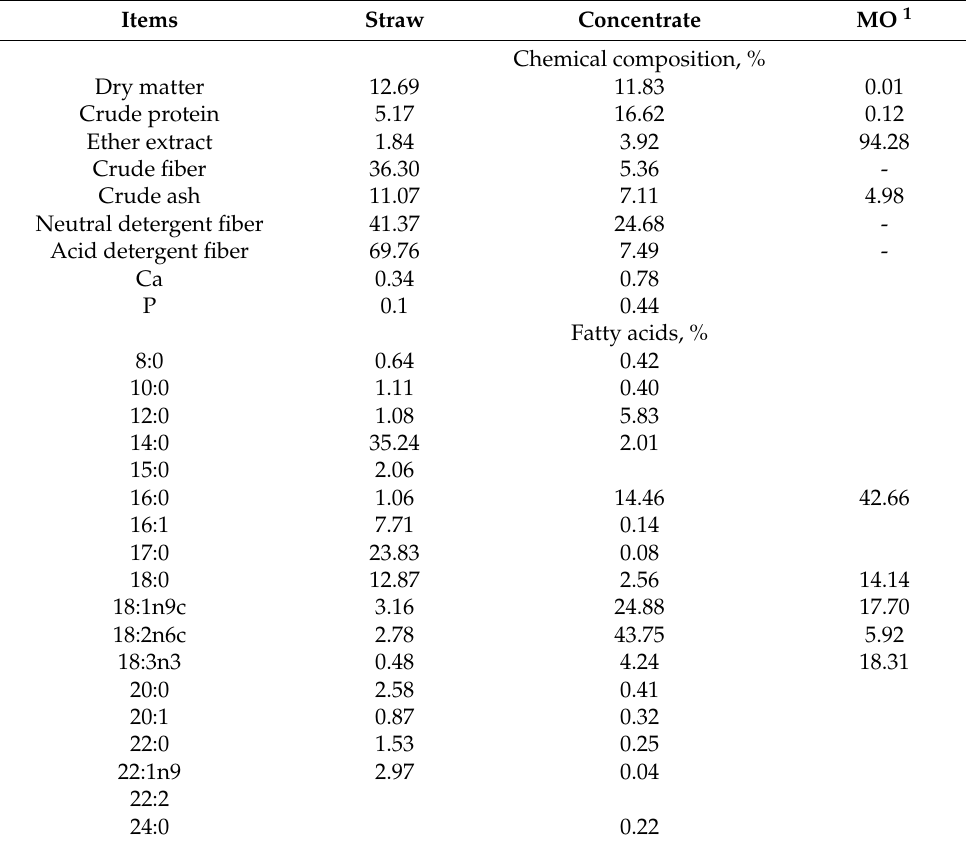
Table 1. Chemical and fatty acid compositions of the steers’